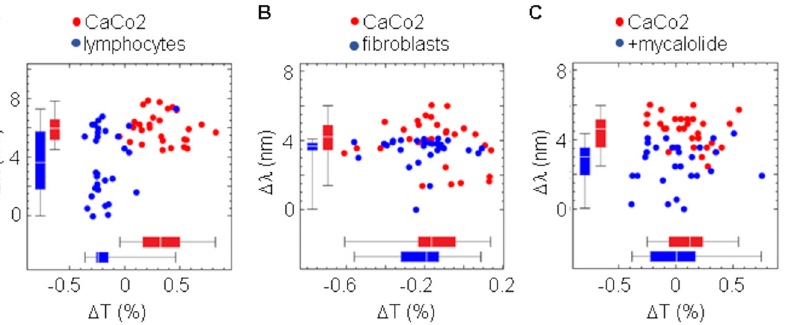
Figure 8: Actin cortex plays a major role in the spectral differences between CaCo2 cells and normal primary cells. (A) Spectral shift and change in transmittance comparing CaCo2 and peripheral blood lymphocytes. Threshold was set to 5.2 nm and sensitivity (71%) and speci fi city (60%) were determined. (B) Spectral shift and change in transmittance comparing CaCo2 and epidermal fi broblasts. Threshold was set to 4.0 nm and sensitivity (60%) and speci fi city (90%) were determined. (C) CaCo2 cells were incubated with actin depolarizing agentmycalolideB(5 μ Mfor1 hat 37 ° C)andthenspectralshift andchange intransmittanceweredeterminedinindividual cells either untreated or treated with mycalolide B. Threshold was set to 4.0 nm and sensitivity (70%) and speci fi city (85%) were determined.